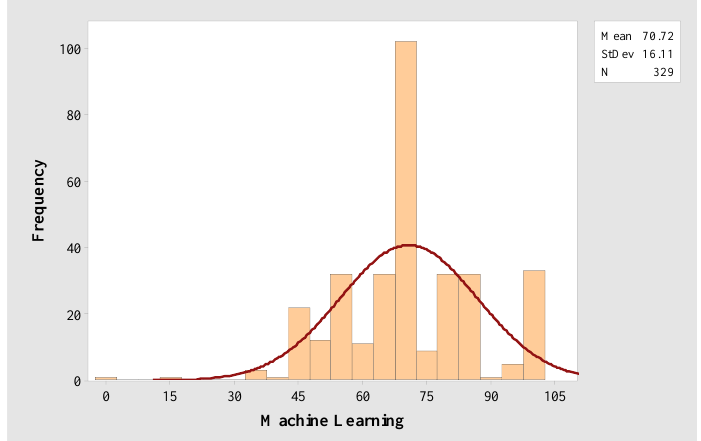
Figure 6: Histogram of the distribution of the level of machine learning